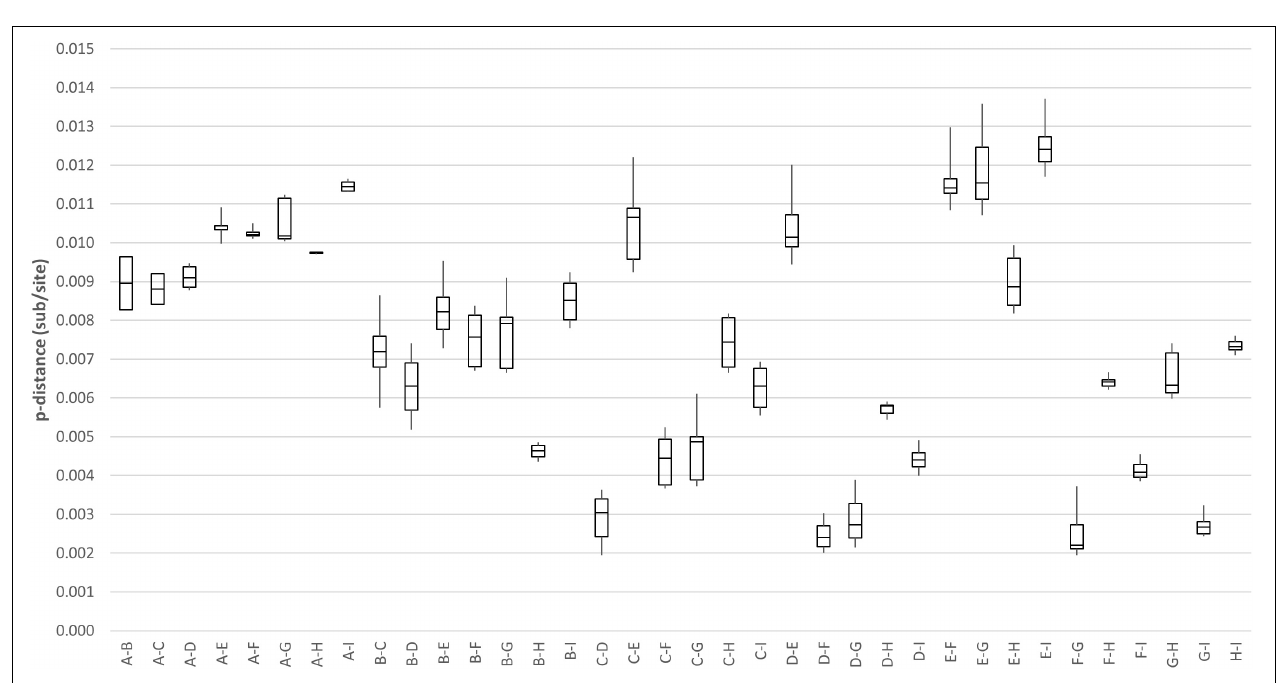
FIGURE 3 | Estimation of pairwise genetic distances between genotype I and other existing genotypes of HCoV-OC43 based on the whole-genome sequences.